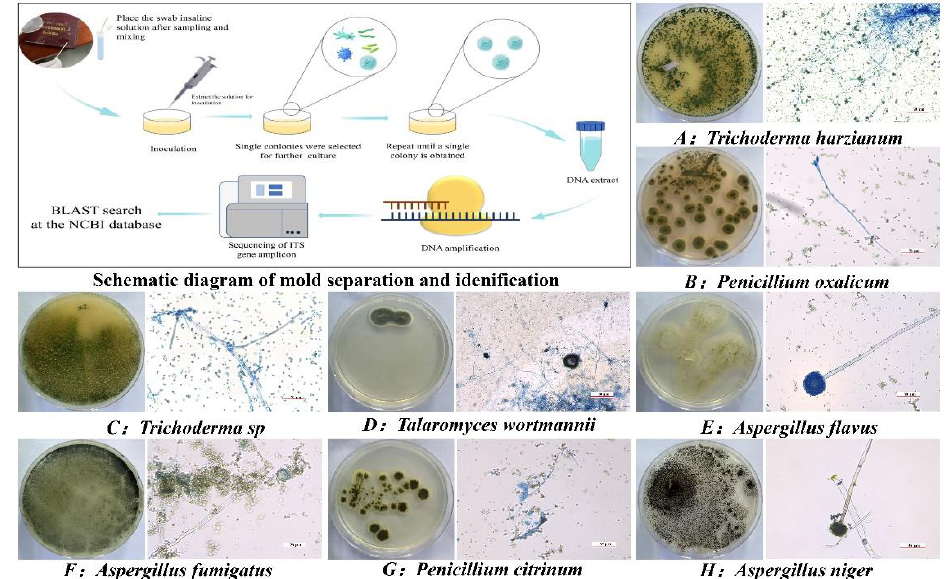
Figure 3. Isolation and identification of related molds in the paper archives. Plate colony morphology (right-hand), spore hypha morphology (left-hand).